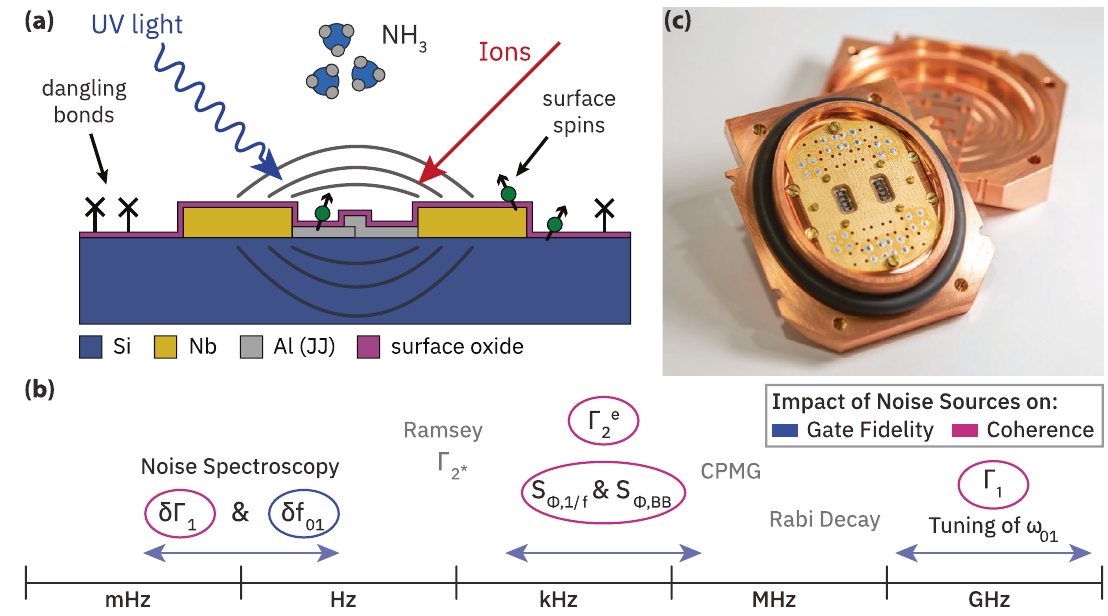
Fig. 1 Noise and decoherence from microscopic defects and adsorbates. a Schematic of treatments and impacted surfaces. b Spectral sensitivity of qubit noise measurements: δ Γ 1 and δ f 01 denote low-frequency parameter fl uctuations as measured by the widths of long-term Γ (cid:1) Γ probes frequency fl uctuations over the full Ramsey averaging time whereas Hahn, and CPMG echo sequences probe 1 and f 01 histograms. 2 noise only above a cut-off frequency. S Φ ,1/ f and S ϕ ,BB denote 1/ f and broadband fl ux-noise powers extracted from the fl ux dependence of Γ e Rabi decay probes noise at the qubit Rabi frequency and Γ 1 spectroscopy are sensitive to noise at the qubit frequency. c Image of the UHV package that can be used to load two-qubit chips in a controlled environment.